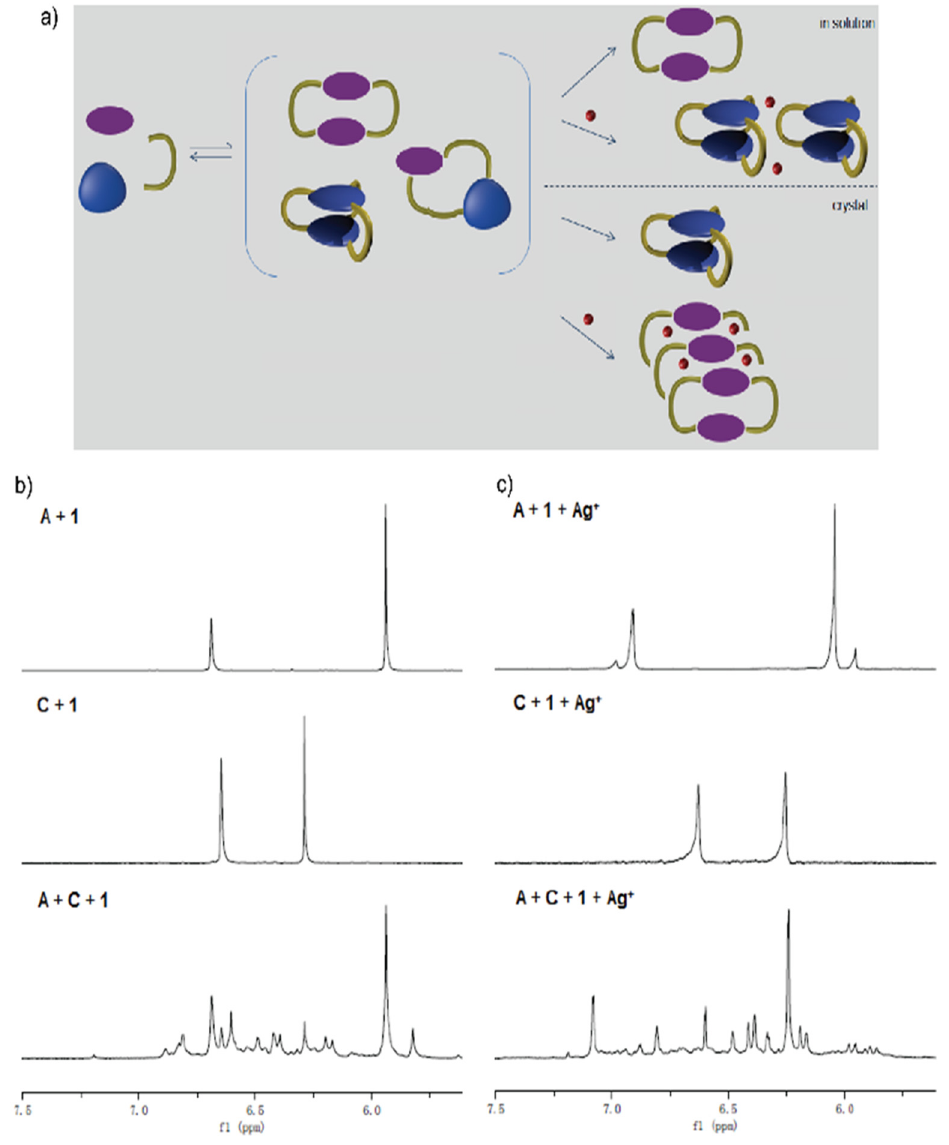
Figure 3. ( a ) Schematic presentation of selection from a dynamic library containing dialdehyde A , trialdehyde C , and amine 1 . 1 H-NMR spectra of L2 ( b ) with the absence and ( c ) with the presence of Ag +